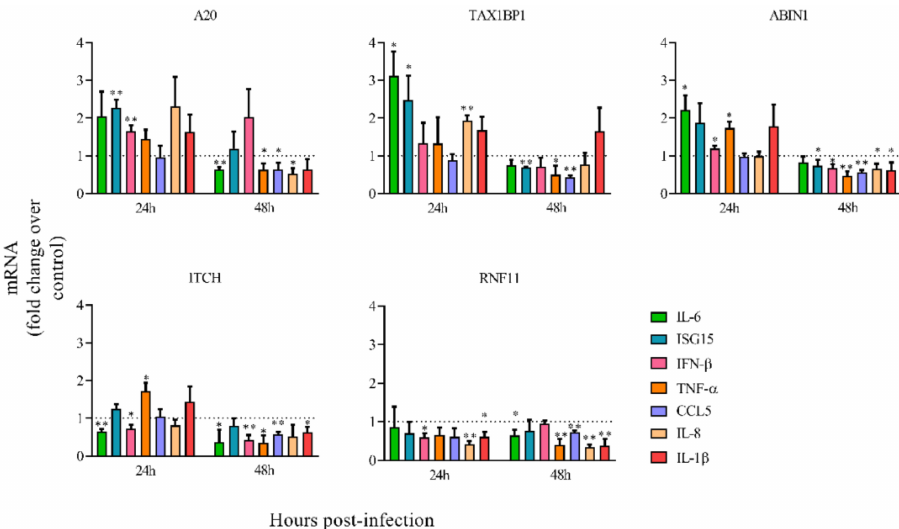
Figure 2. Relative mRNA levels of inflammatory / antiviral genes in cells transfected with di ff erent siRNAs. Cells were transfected with the indicated siRNAs (A20, TAX1BP1, ABIN1, ITCH, RNF11) and infected 24 h later at a MOI of 3. Levels of mRNAs were quantified by qRT-PCR at 24 and 48 hpi and represented as fold-over mRNAs expressed in cells transfected with a control siRNA and infected 24 h later at a MOI of 3. Data are represented as the mean and standard deviation from three independent experiments. Pairwise comparisons between cells transfected with a specific siRNA and cells transfected with the control siRNA, were done for each gene and time post-infection by using the t -test. From the p values obtained, False Discovery Rates (FDRs) were calculated: *, q-value < 0.05 and **, q-value < 0.01. Fold change = 1 means that there is no expression change with respect to the control (cells transfected with a siRNA control) and is represented by a dotted line.